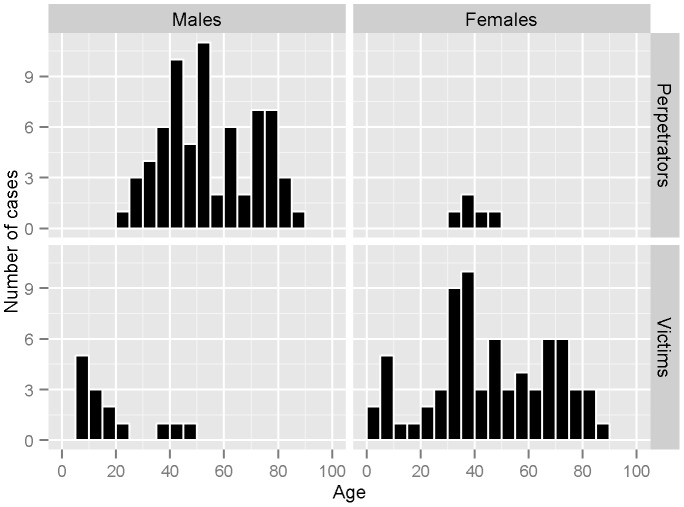
Age distribution of homicide and suicide victims across genders.Homicide–suicide events in Swiss households 1991–2008.